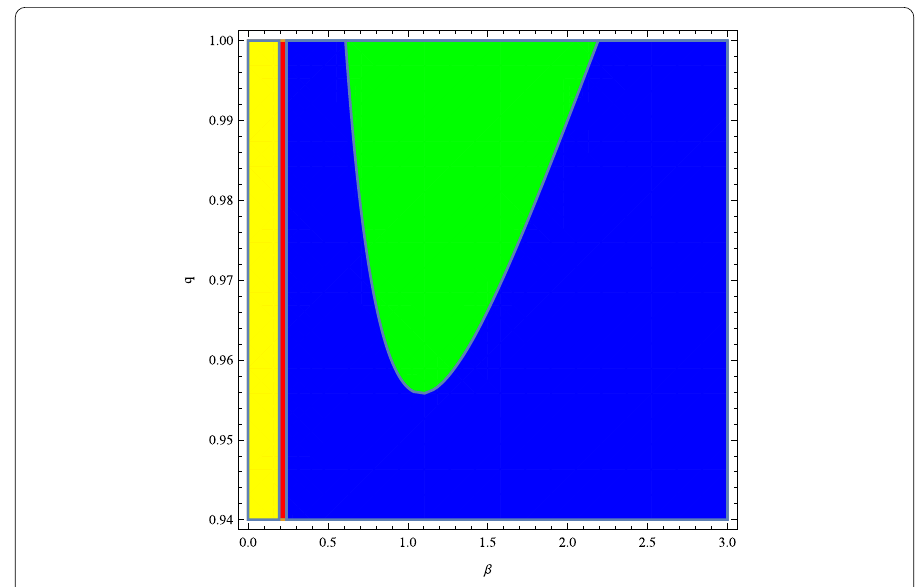
Figure 6 Stability regions of the fractional-order model (3) in the( β – q )